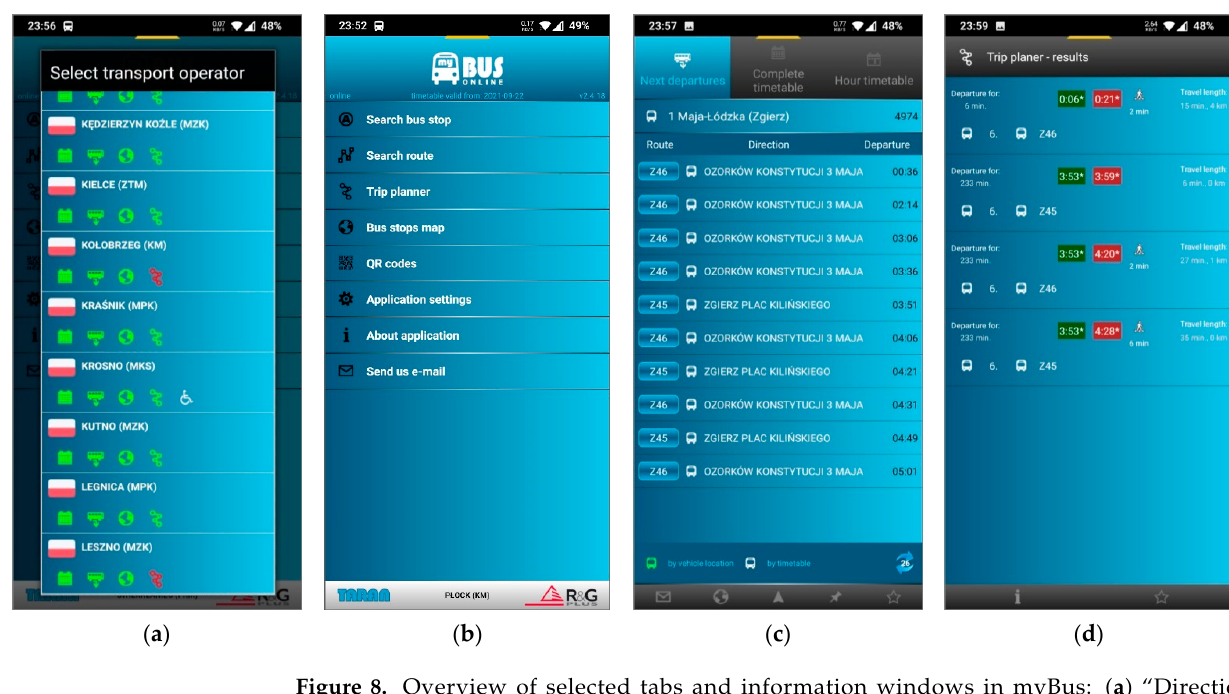
Figure 8. Overview of selected tabs and information windows in myBus: ( a ) “Directions”; ( b ) “Stations”; ( c ) “Lines”; ( d ) proposed route information window.